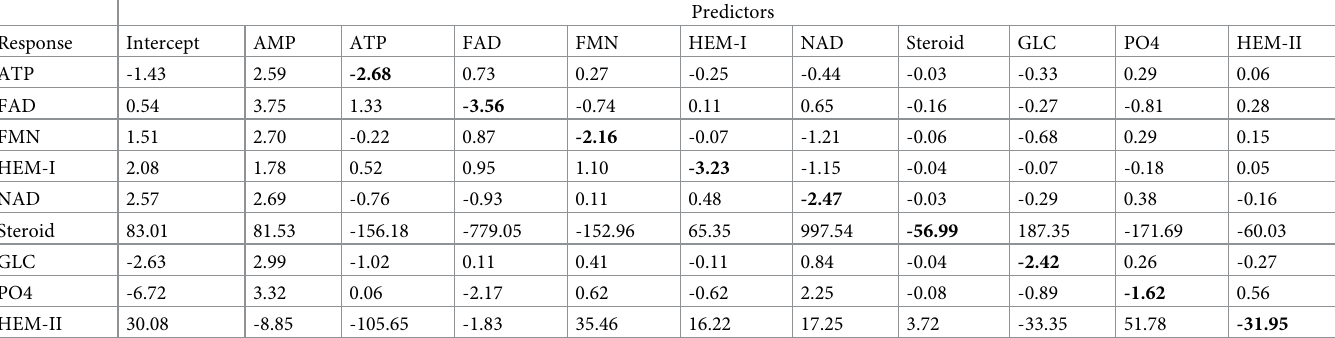
Table 7. Coefficients of the polytomous logistic regression model for the extended Kahraman